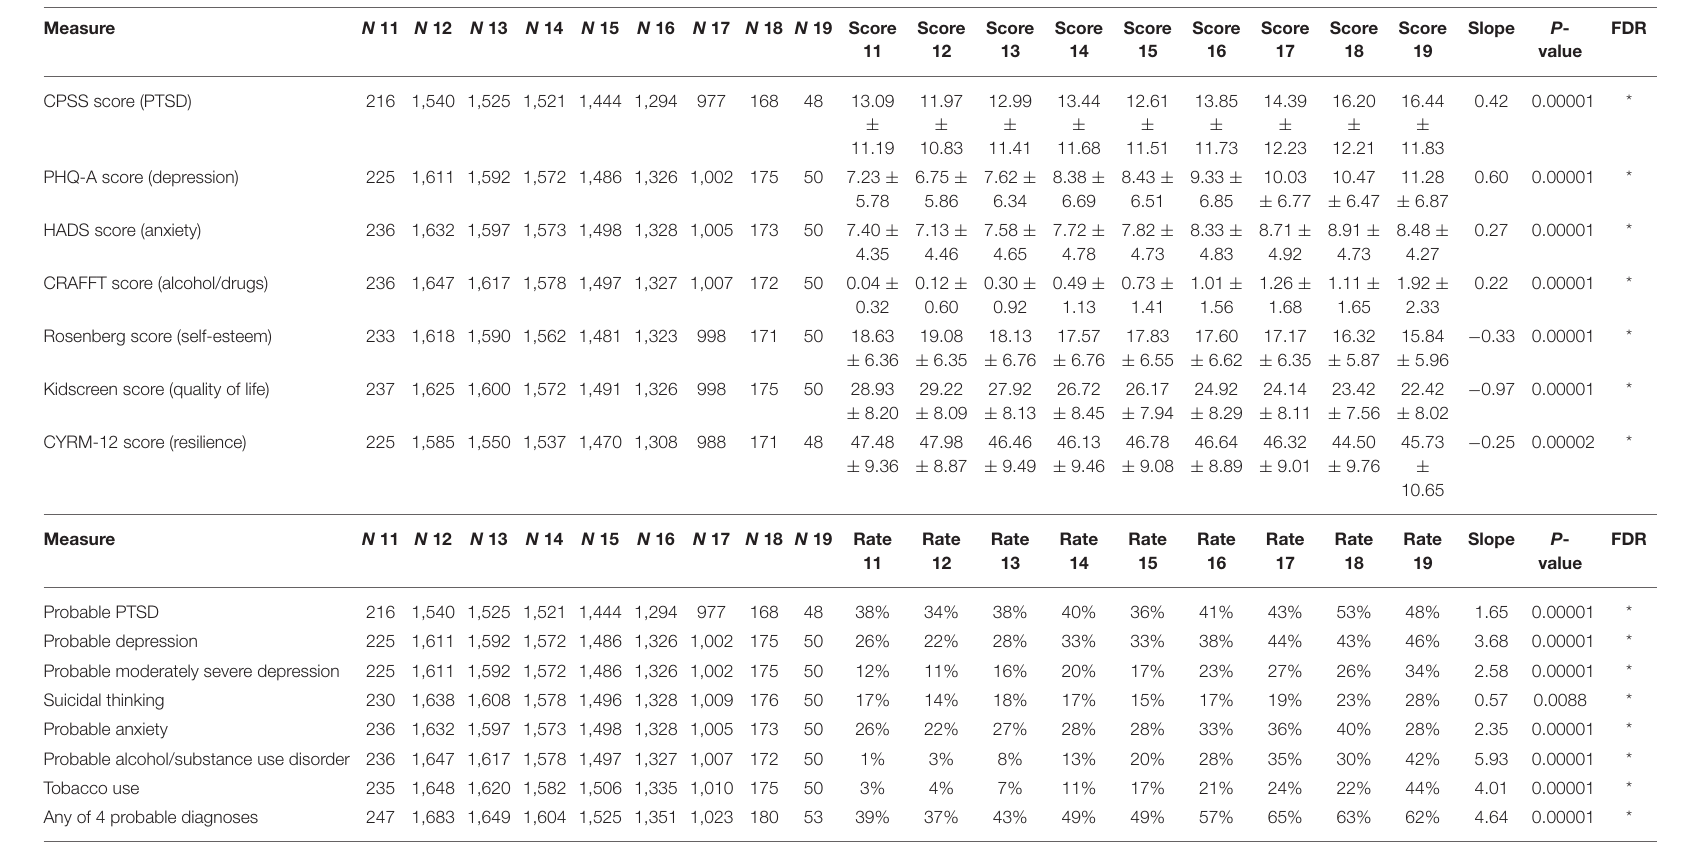
TABLE 4 | Effects of age (11–19 years old).